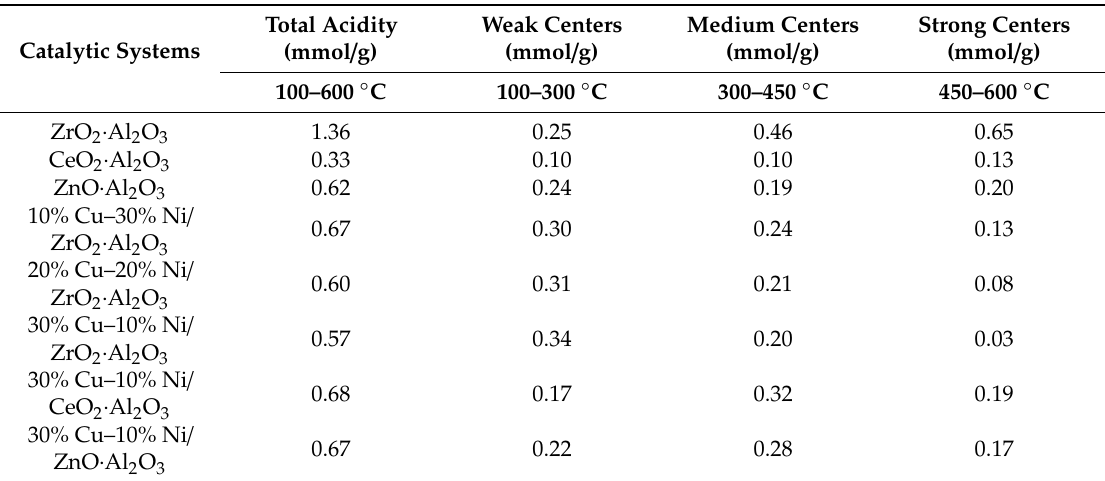
Table 3. TPD-NH 3 measurements of calcined supports and bimetallic Cu-Ni